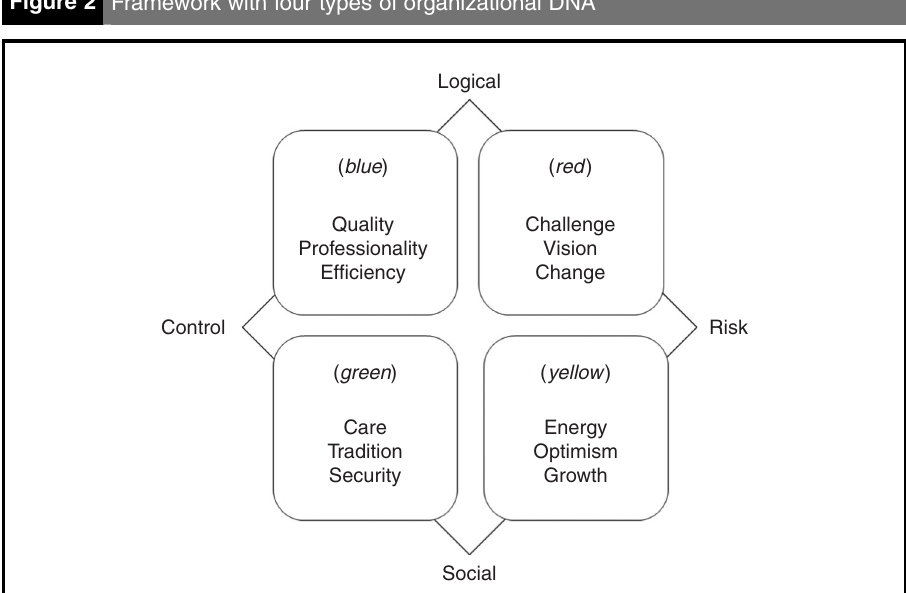
Figure 2 Framework with four types of organizational DNA